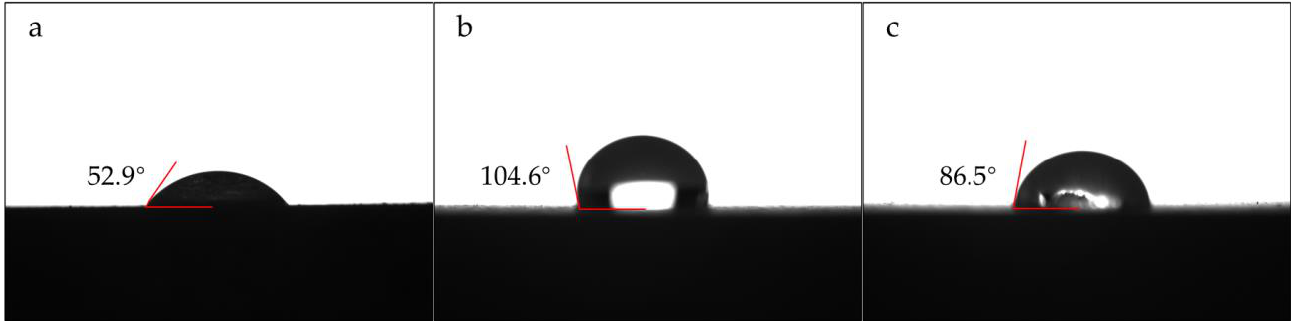
Figure 6. Water contact angles of samples: ( a ) DM; ( b ) H1; ( c ) H2. The Ca 2+ release of samples with coatings is visibly lower than that of the untreated reference, shown in Figure 7a. According to the concentration of Ca 2+ ions in the runoff solution, the GQD‑enhanced film prevented the corrosion resulting from simulated acid rain efficaciously, and even the discontinuous HAP film could also improve the acid resis‑ tance. Thanks to the improved hydrophobicity, H1 exhibits the minimum mass loss ratio and highest coefficient of frost resistivity, which are consistent with better freeze–thaw re‑ sistance, as displayed in Figure 7b. Similarly, the film on H2 can improve the property to some